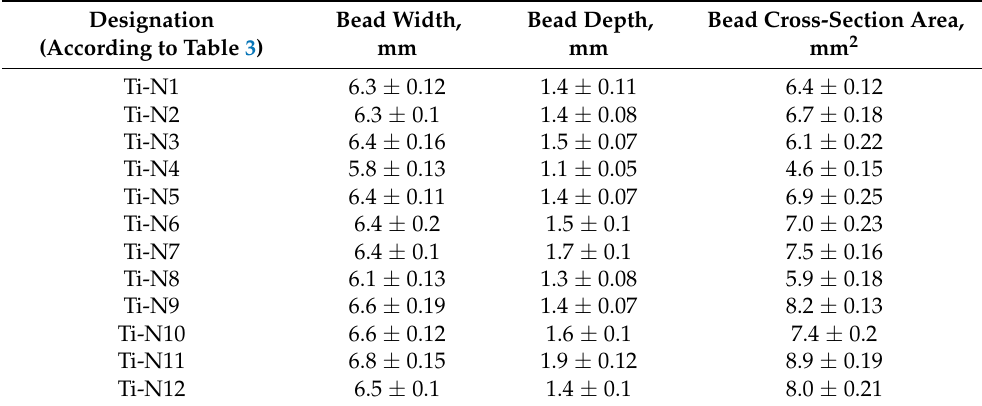
Figure 3. The macrostructure of the representative laser-alloyed surface layer. Table 4. The laser-alloyed beads’ depth, width and cross-section area measurements results (designa- tion in accordance with Table